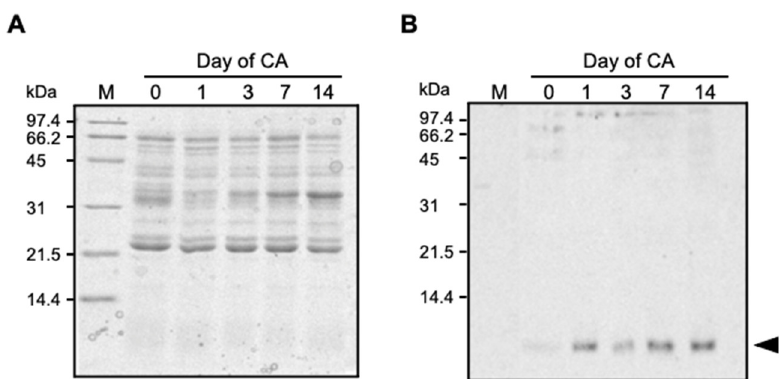
Figure 1. Western blot analysis of cold-acclimated wheat apoplastic protein extracts. ( A , B ) Apoplastic proteins from a time course of cold treatment were separated by SDS-PAGE ( A ), and a duplicated gel was transferred to a membrane for Western blot analysis ( B ). CA, cold acclimation.